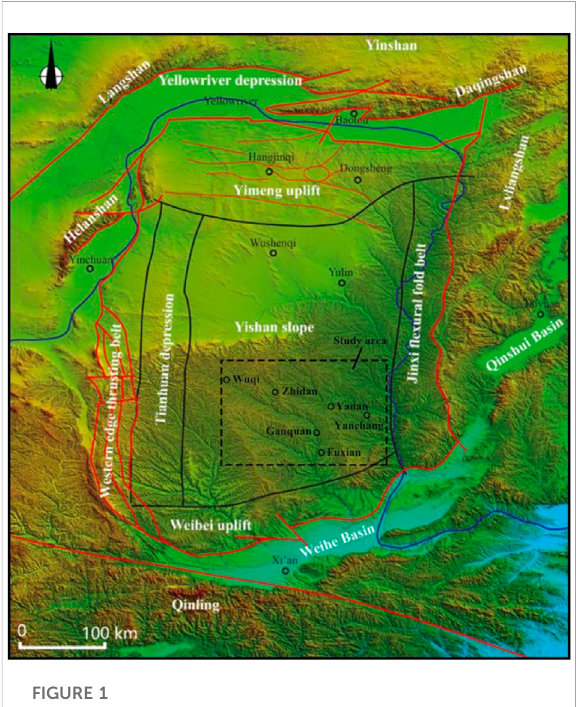
FIGURE 1 Location of the study area (modi fi ed by Xu et al.,